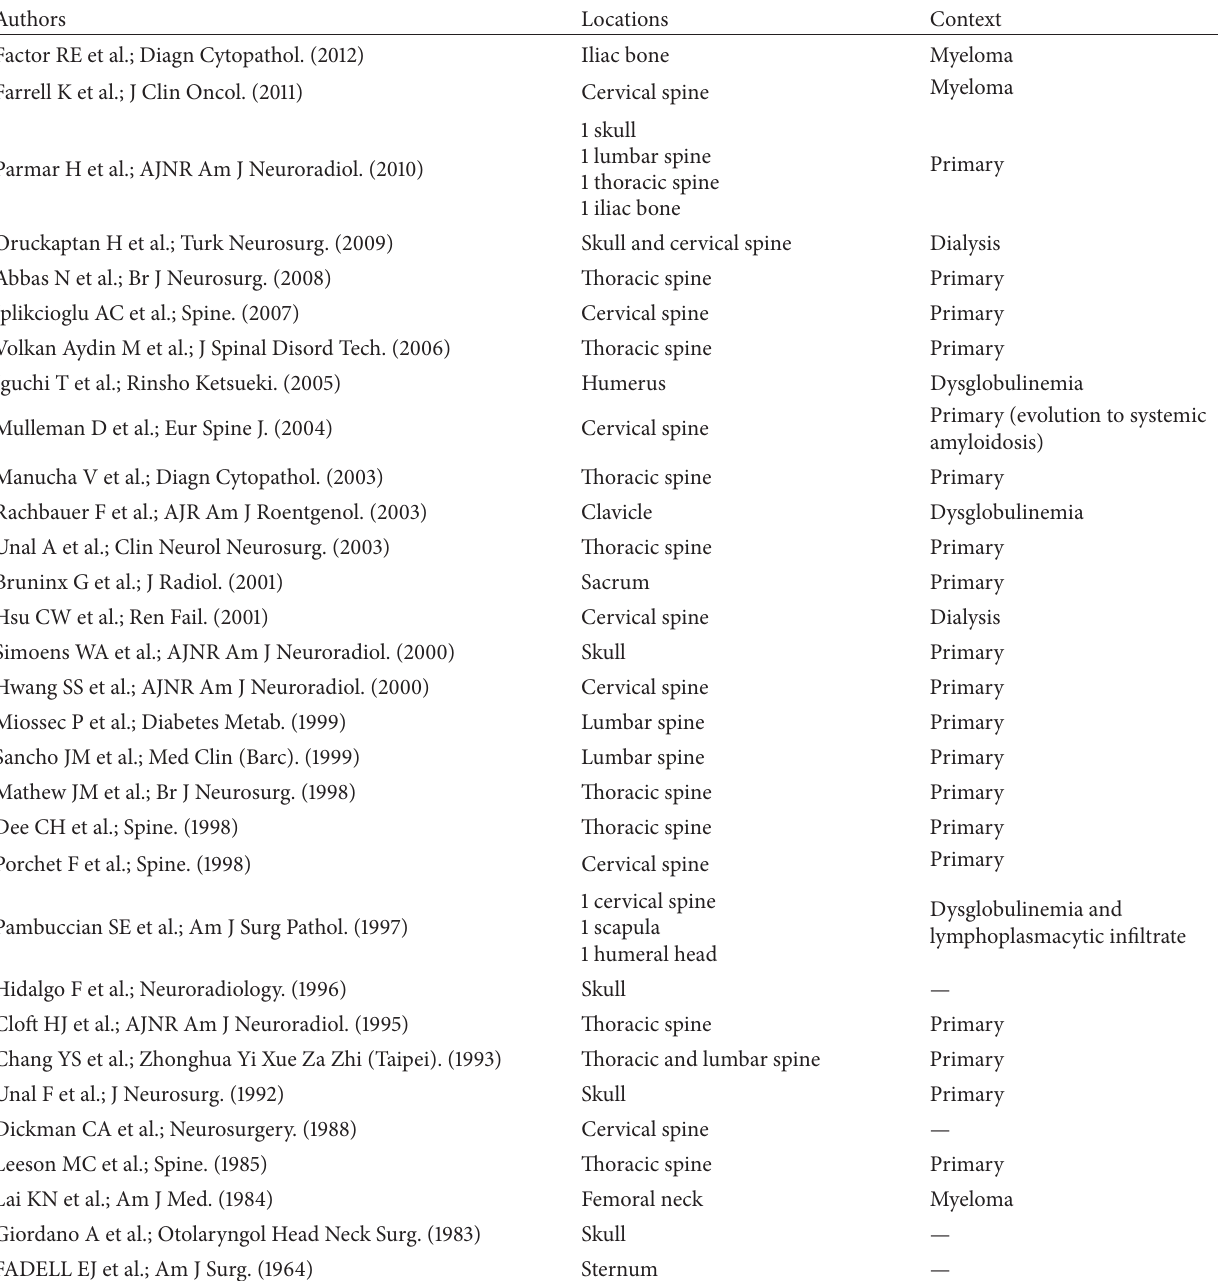
Table 1: Bone locations of